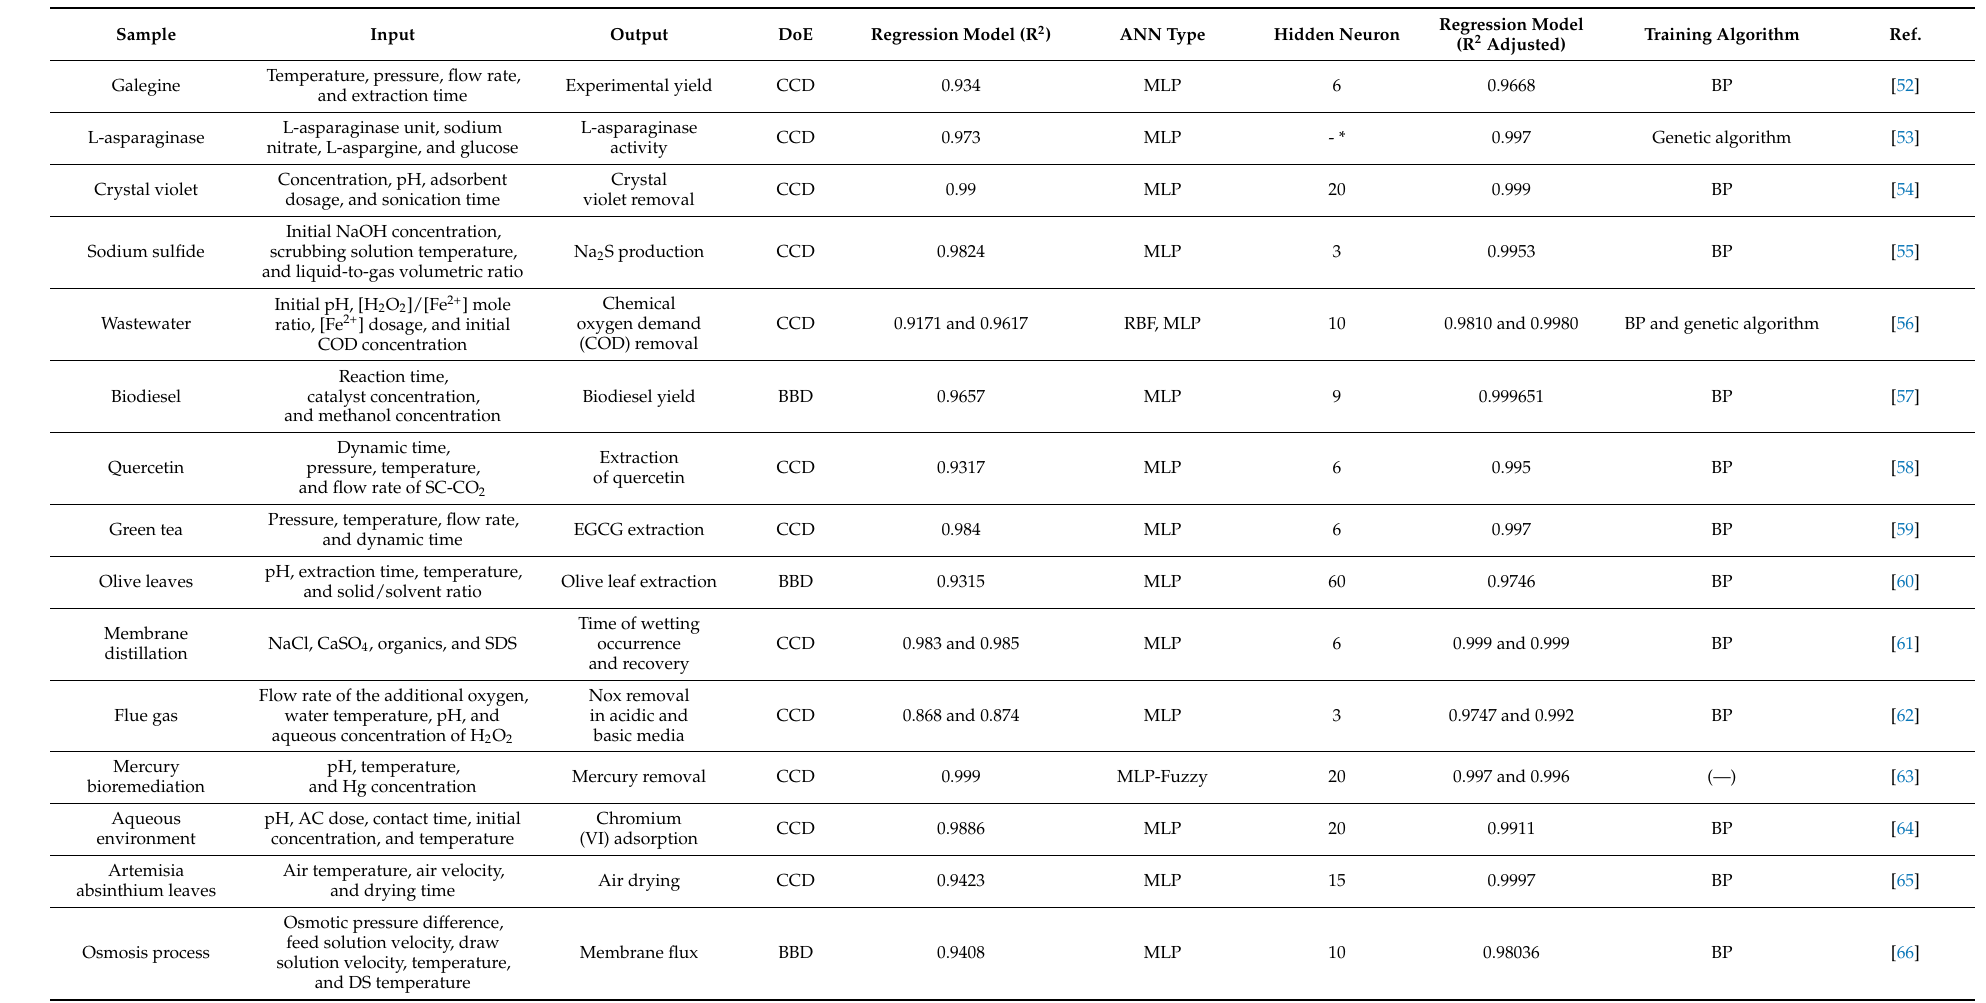
Table 2. Examples of ANNs used in modeling DoE